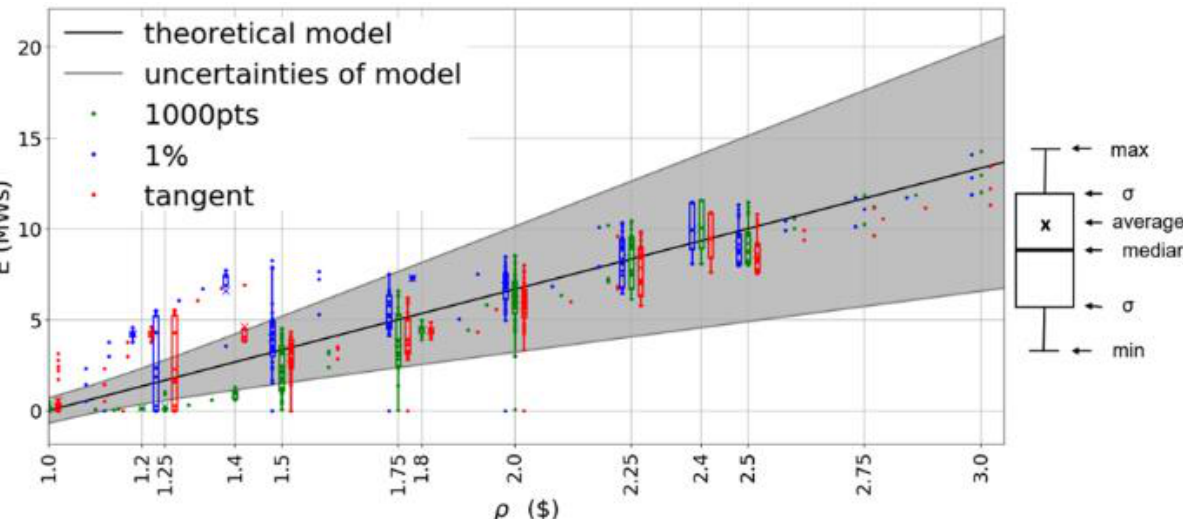
Figure 7: The comparison of the theoretical models with the experimental data for total energy released with three different integration models.